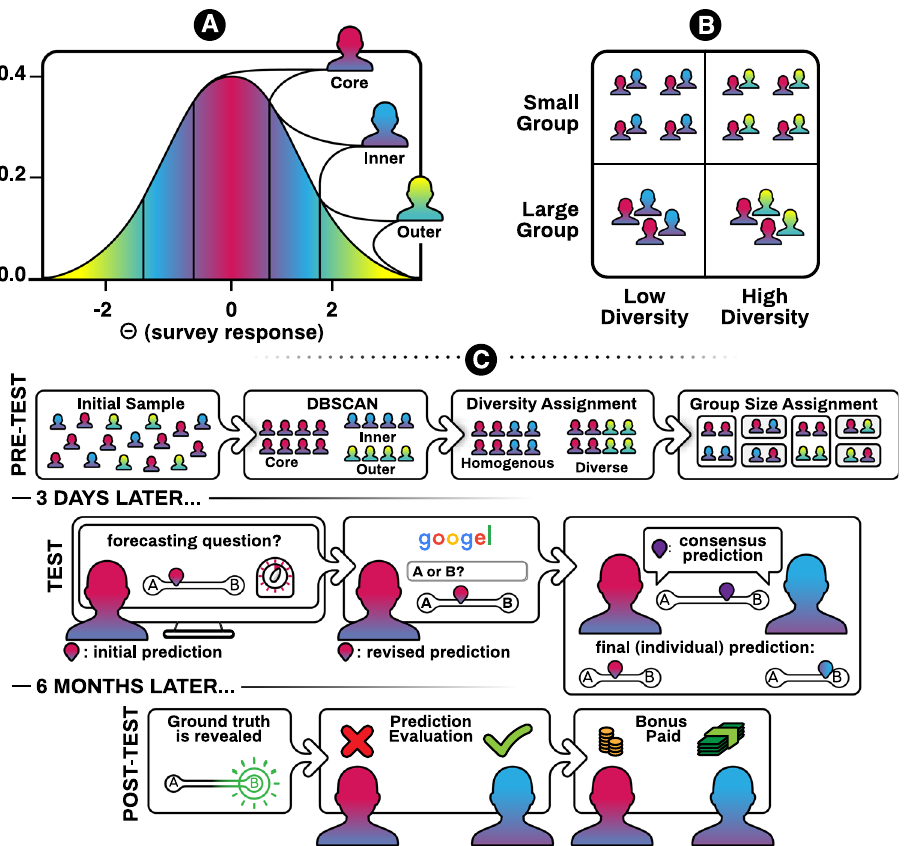
Fig. 1 Experimental design. A One-dimensional representation of the partitioning of the Θ space by the DBSCAN algorithm. In reality, Θ 2 R D , where D is the number of dimensions considered ( D = 29). B 2 × 2 design with factors: diversity (low vs. high) × modularity (low vs. high). Low vs. high diversity manipulation was achieved by matching the core participants to either the inner segment participants (low diversity condition) or the outer segment (high diversity condition). C Experimental procedure. At pretest time (upper row), participants were administered a battery of surveys that were used to cluster them into a core, inner, and outer segments (DBSCAN). Core participants were then randomized to a diversity and modularity condition. At test time,